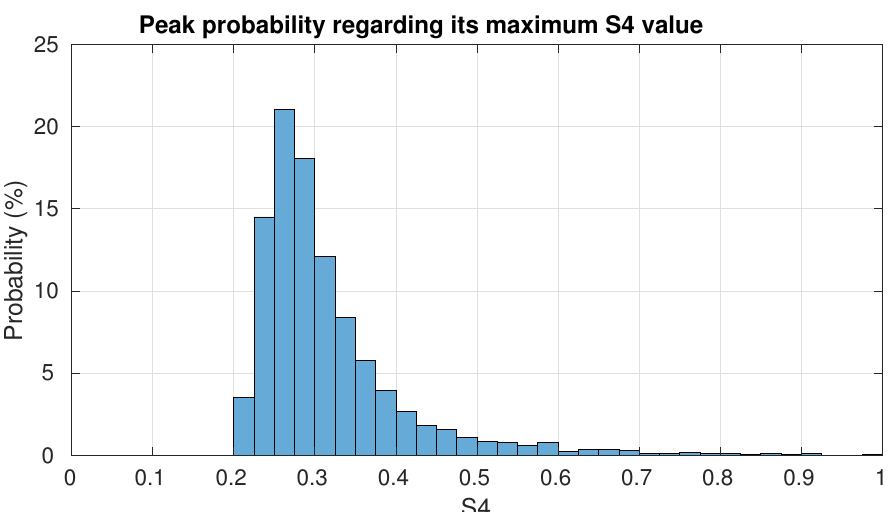
Figure 16. Histogram of number of events wrt its LT.